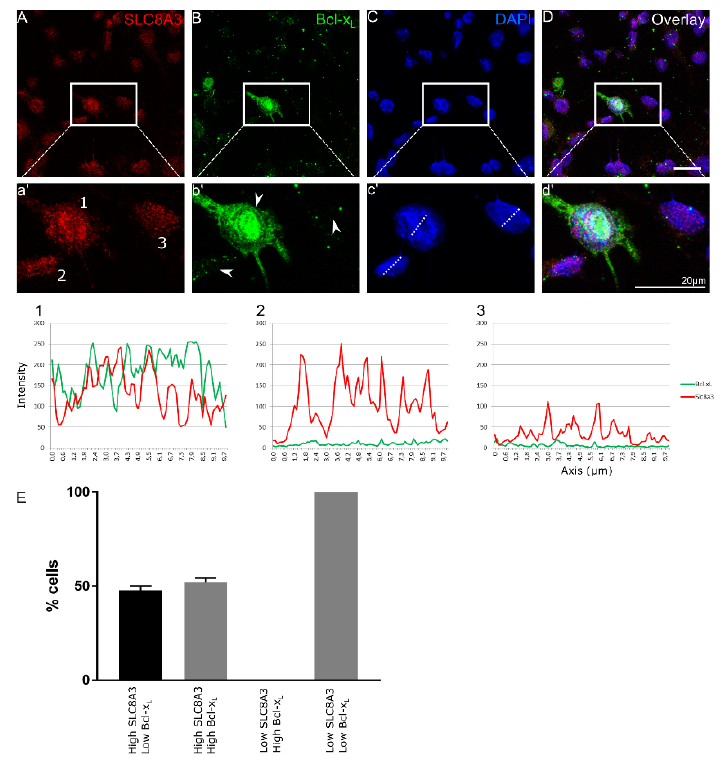
Figure 2. SLC8A3 and Bcl-xL expression correlate in developing Engrailed 1-derived midbrain and hindbrain neurons. ( A – D ) Confocal double immunofluorescent representative labelling of SLC8A3 (red) and the anti-apoptotic marker Bcl-xL (green) in primary T β RII flox / flox ::En1 cre /+ neuronal ventral midbrain / hindbrain cultures at E14 show either high or low SLC8A3 expression and high or low Bcl-xL expression. Line scan (1) is a representative image of a neuron with high SLC8A3 expression and high Bcl-xL expression (neuron 1 in the magnification of the white boxed area). Line scan (2) depicts neurons with high SLC8A3 expression while Bcl-xL is low (neuron 2 in the magnification of the white boxed area). Line scan (3) shows low cellular SLC8A3 abundance together with low Bcl-xL (neuron 3 in the magnification of the white boxed area). Arrowheads correspond to cells 1-3. ( E ) Quantification of number of cells (%) based on high / low SLC8A3 and high / low Bcl-xL expression (total: 96 cells from 3 independent experiments).